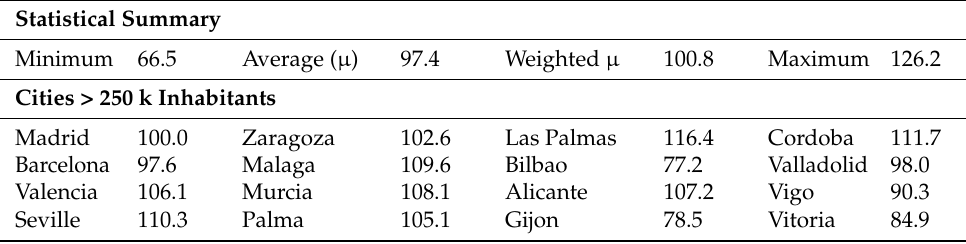
Figure 5. Contribution to household consumption in % combining PV and ST. Table 14. Contribution to household consumption in % combining PV and